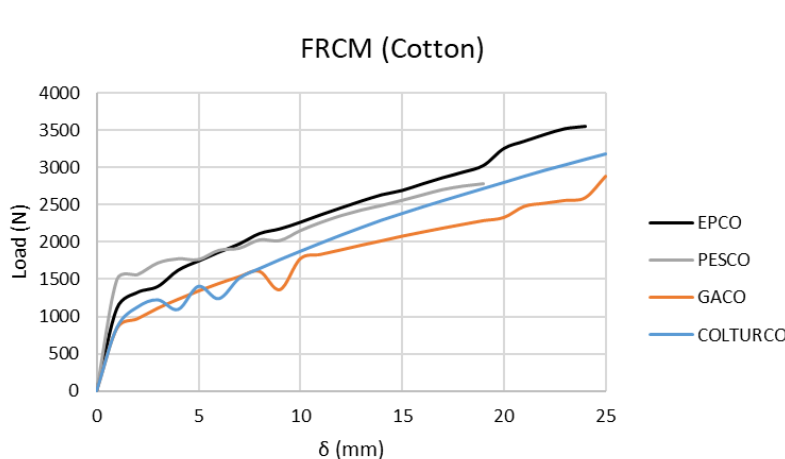
Figures 9 and 10 correspond to the average load – extensometer curves of each case.